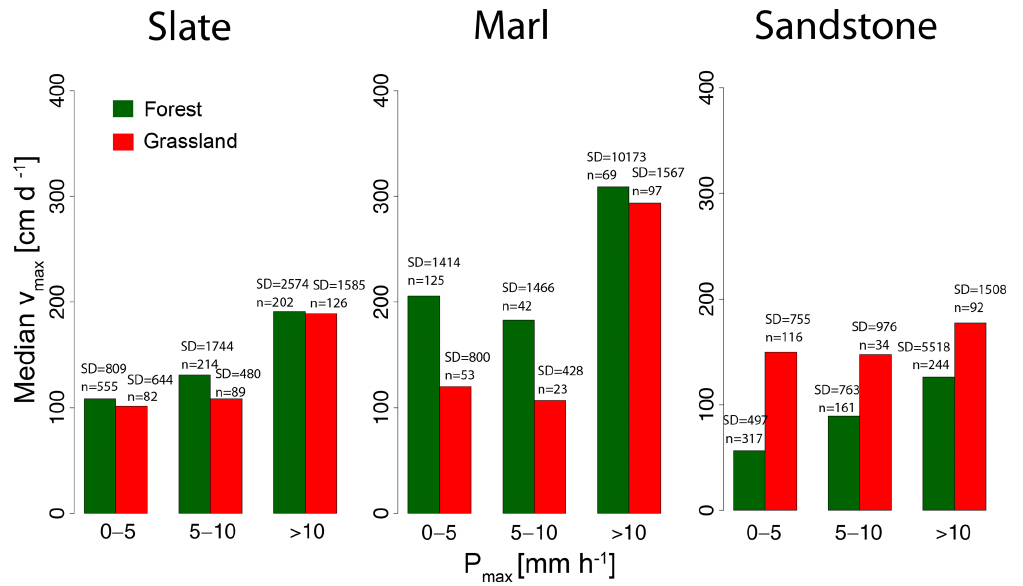
Figure 10. Median v max vs. P max . The numbers above the bars indicate the number of events included in the analysis ( n ) and the standard deviation